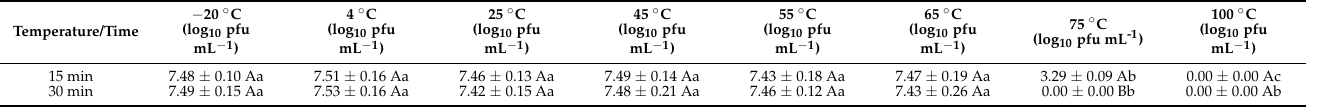
Table 3. Stability of the phage UAE_MI-01 at different temperatures.